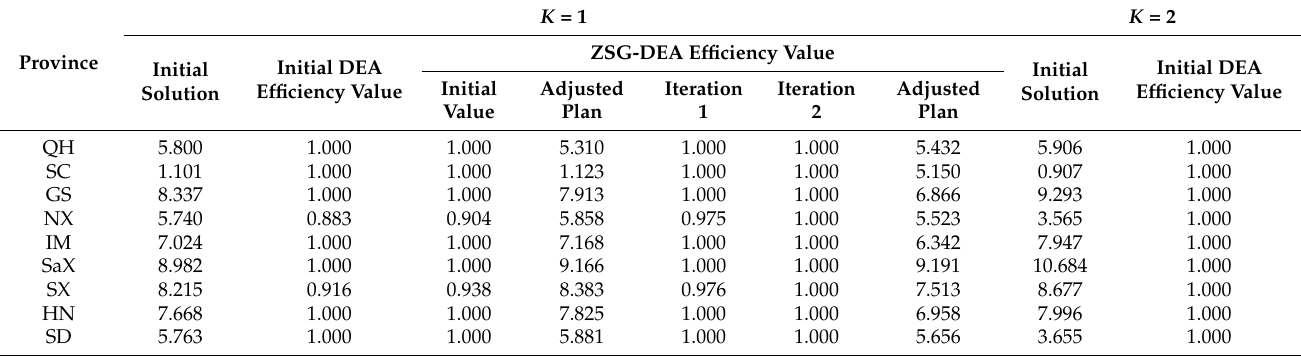
Table 2. Iteration results and efficiency values of COD allocation lower limit under 2030 scenario h = 1.